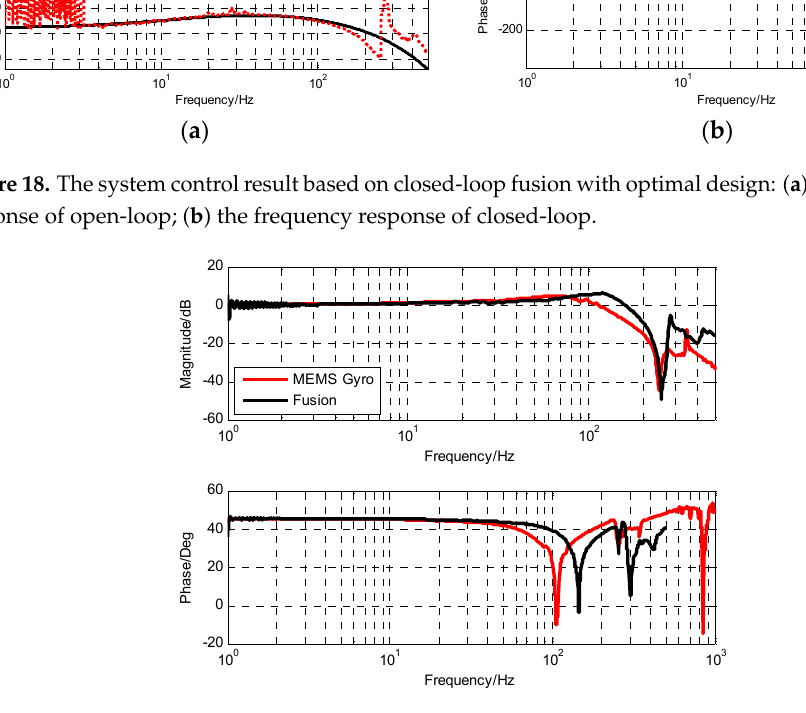
Figure 19. Closed-loop result comparison diagram.